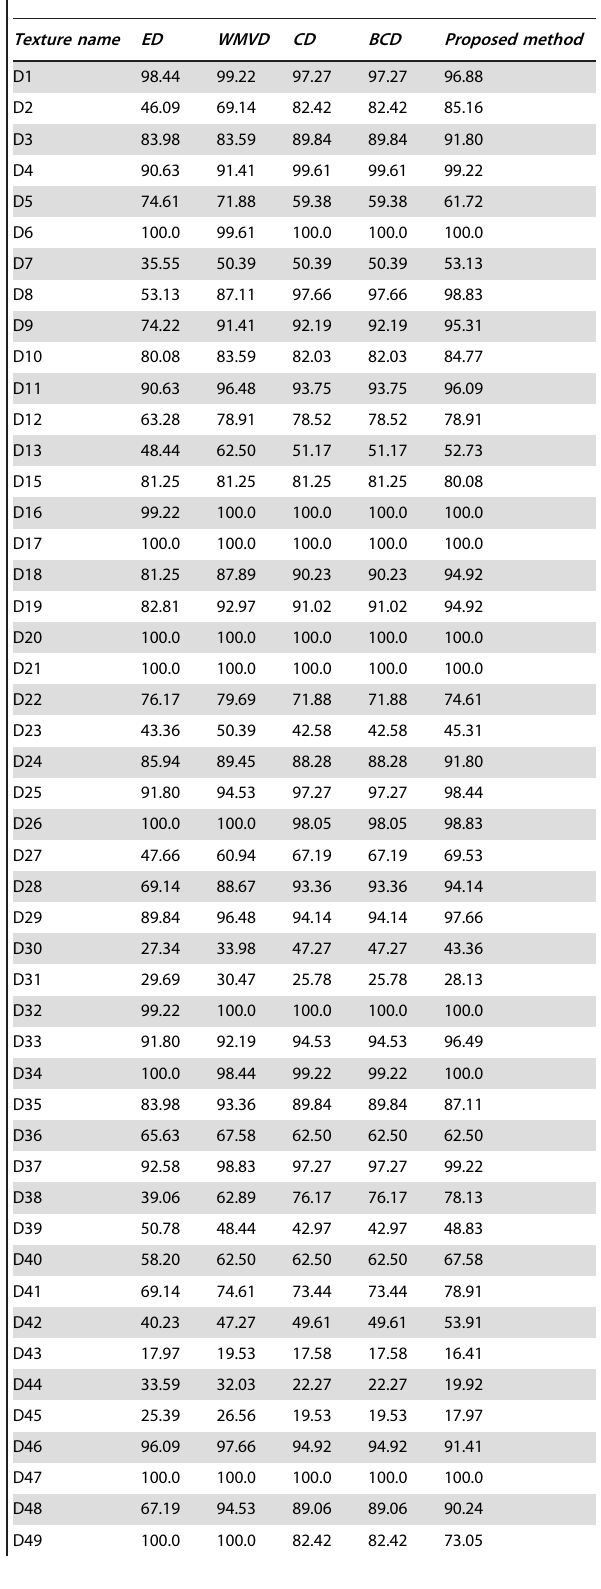
types of metrics for texture image retrieval using DT-CWT on the Brodatz image database (1776 images of 111 different